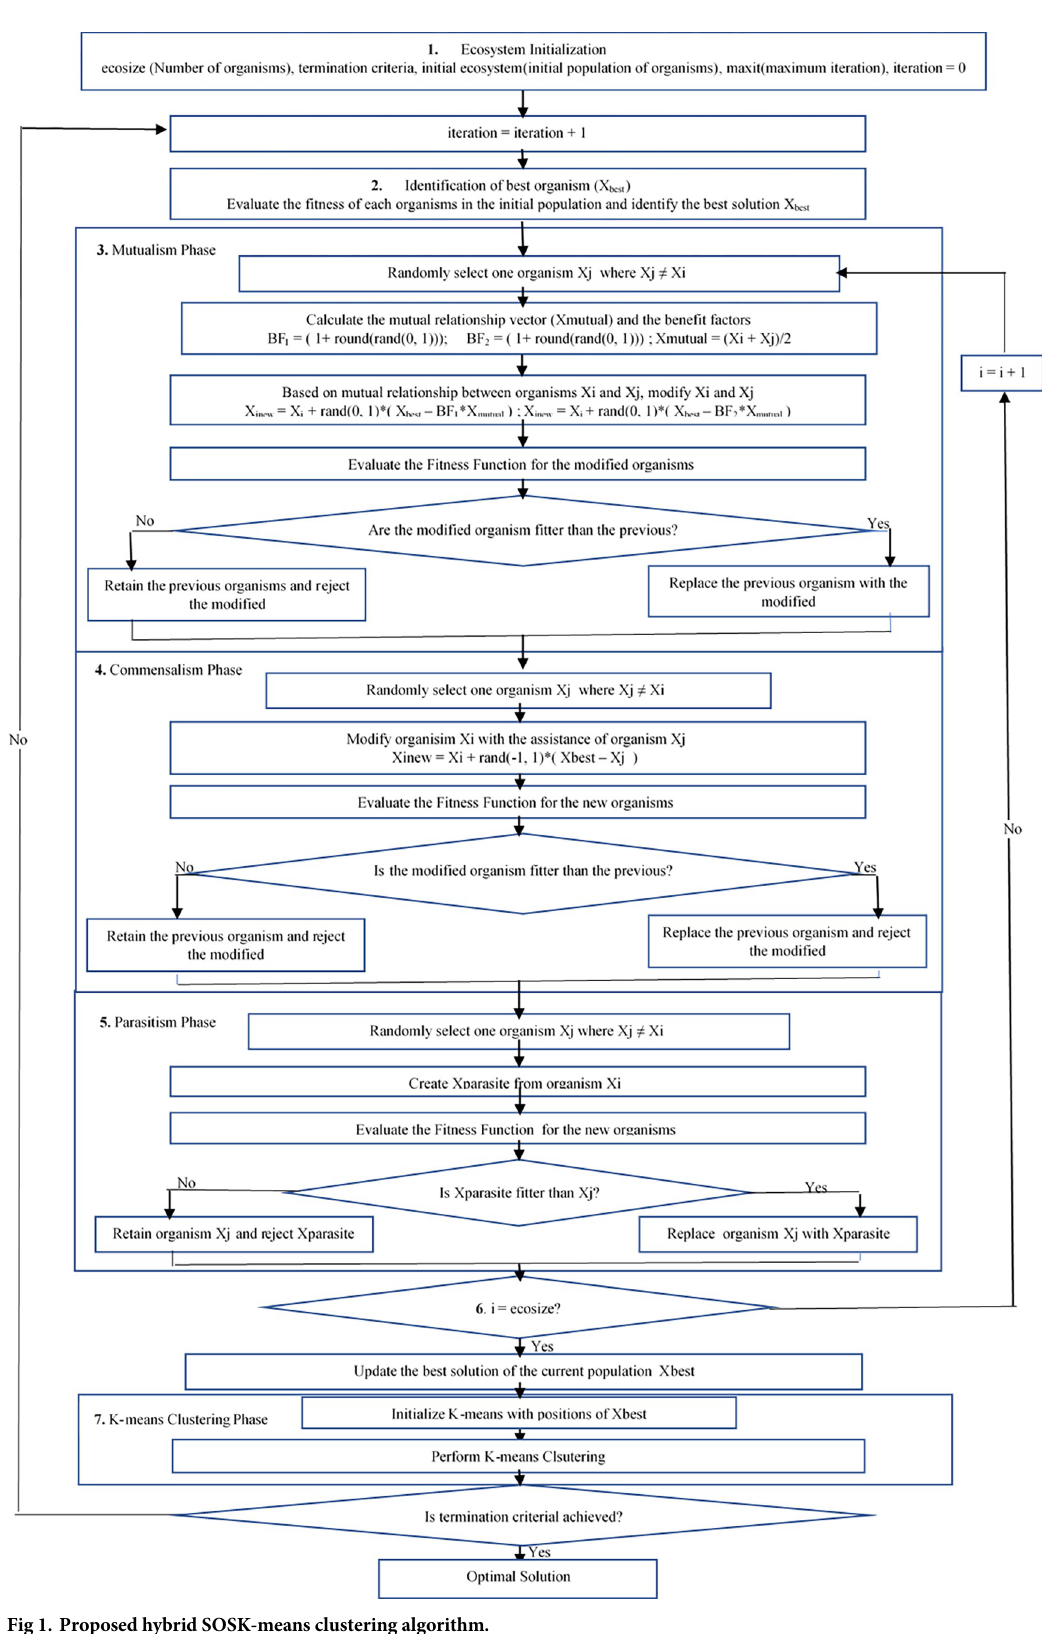
Fig 1. Proposed hybrid SOSK-means clustering